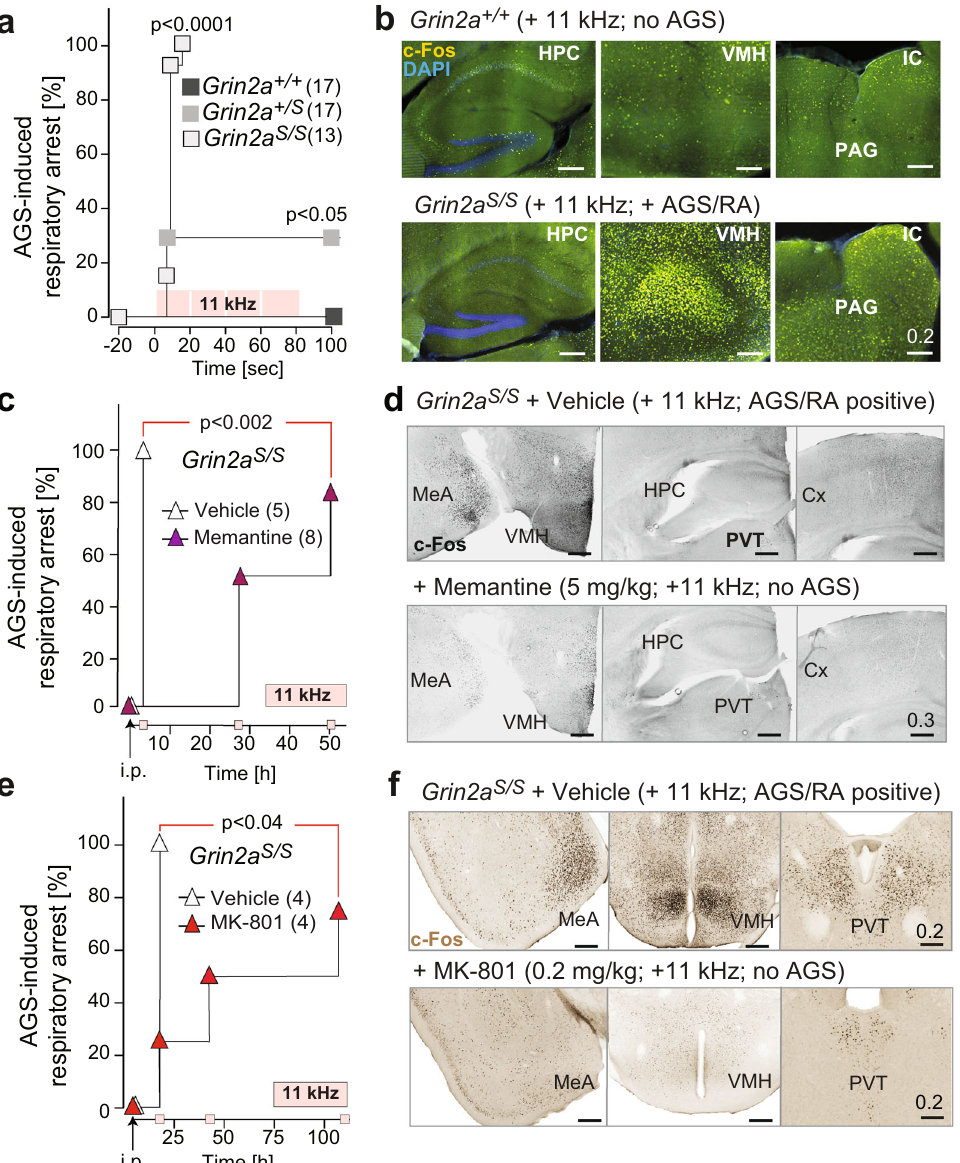
Fig. 4 Grin2a S/S mice are susceptible to brainstem-derived AGS that can be rescued by NMDAR antagonists. a Mortality curve showing that none of the Grin2a + / + controls were affected, while audiogenic seizures (AGSs) followed by respiratory arrest (RA) were induced in all Grin2a S/ S mice and in a subset of heterozygous Grin2a + / S mutants during the 11 kHz tone exposure [4 repetitions × 20 s tone, 2 s brake; pink squares; p < 0.0001 by Log-rank (Mantel – Cox) test]. b The c-Fos immunoreactivity was speci fi cally increased in the hypothalamus (VMH), the inferior colliculus (IC), and periaqueductal gray (PAG) but not in the hippocampus (HPC) of a resuscitated Grin2a S/S mouse 90 min after AGS when compared to tone-exposed Grin2a + / + littermates. c Memantine i.p. injection in Grin2a S/S mice, 3 h before tone exposure, rescued AGS susceptibility in Grin2a S/S mice. The rescue effect could still be observed in four out of eight, and in two out of eight, mice 27 and 51 h after memantine treatment, respectively. d Increased c-Fos immuno fl uorescence (in grayscale) in the medial amygdala (MeA) and the VMH of a Grin2a S/S animal with AGS (saline injection) compared to a memantine rescued Grin2a S/S littermate. In the paraventricular nucleus of the thalamus (PVT), the hippocampus (HPC) and cortex (Cx) there was no difference in c-Fos expression between memantine-injected and saline-injected animals (for fl uorescence images, see Supplementary Fig. 5). e As in Fig. 4c but now MK-801 and saline are used for pre-treatment. The MK-801 effect was longer lasting compared to memantine and one out of four animals showed resistance to tone exposure even 4 days after MK-801 injection. f Decreased c-Fos DAB immunosignal in an MK-801 AGS-rescued Grin2a S/S animal (bottom) in the medial amygdala (MeA), the VMH and the PVT when compared to saline-injected Grin2a S/S littermate (top). Scale bars are in mm (for statistics: Supplementary Statistics to Fig. with an alternative NMDAR blocker, MK-801, at low doses (0.2 ( N = 4). Again, AGS-resistant, MK-801-injected Grin2a S/S mice mg/kg i.p.), the AGS inhibition was similarly effective and even showed no c-Fos induction in those brain regions normally longer lasting (Fig. 4e). The ef fi ciency of MK-801 in reducing the associated with AGSs (Fig. 4f). The pharmacological rescue of incidence of AGS was highly signi fi cant 18 h post-injection and AGS in GluN2A(N615S)-expressing mice points to a direct lasted up to 4 days in half of the MK-801-treated Grin2a S/S mice involvement of the aberrant NMDAR signaling in the exaggerated